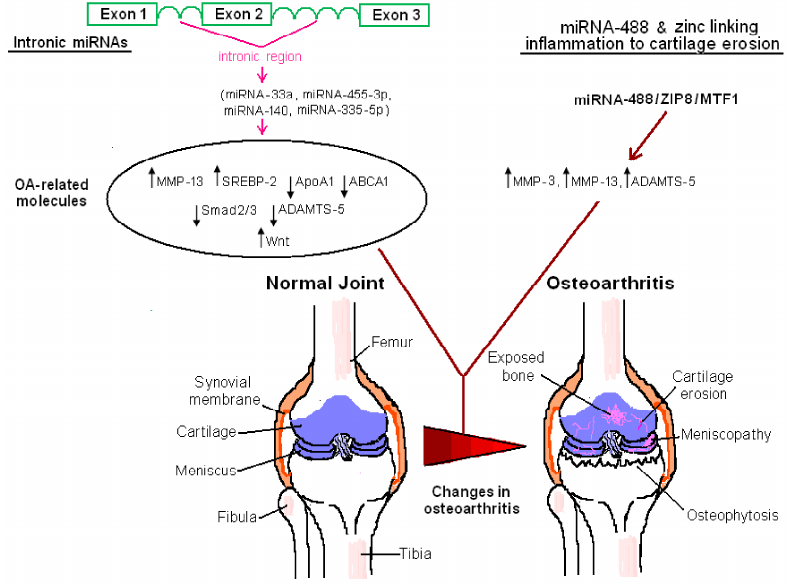
Figure 1. Intronic microRNAs (miRNAs) and the miRNA ‐ 488/ZIP8/MTF1 pathway are critically involved in the pathogenesis of osteoarthritis (OA). Distinct miRNAs (miRNA-33a, miRNA-455-3p, miRNA-140, and miRNA-335-5p) reside within intronic regions of human genes and they modulate the expression of a series of molecules either positively (upward pointing arrows) or negatively (downward pointing arrows) associated with the development of osteoarthritis. These molecules include proteases responsible for the degradation of cartilage matrix (matrix metalloproteases (MMPs), A Disintegrin and Metalloproteinase with Thrombospondin Motifs 5 (ADAMTS5)), molecules related with cholesterol synthesis and efflux in OA chondrocytes (sterol regulatory element binding protein 2 (SREBP-2), apolipoprotein A1 (ApoA1), and ATP binding cassette subfamily A member 1